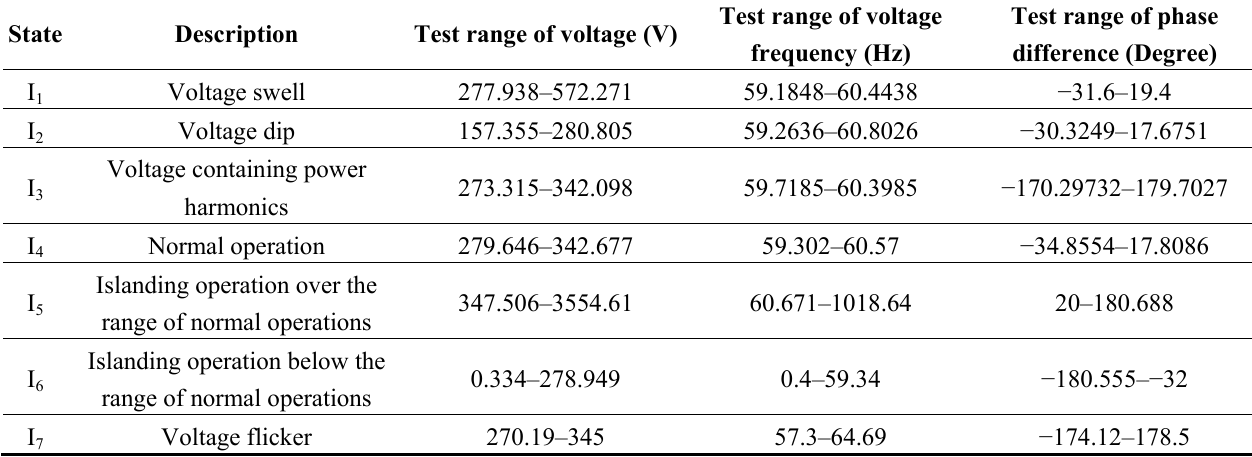
Table 3. States for detecting islanding operation.